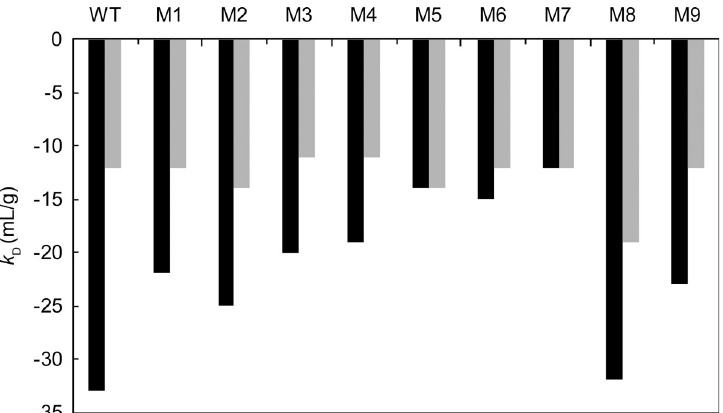
Fig 4. k D values in the presence of 15 mM NaCl and 150 mM NaCl. Black bars show k D values in buffer A containing 15 mM NaCl. Gray bars show k D values in buffer B containing 150 mM